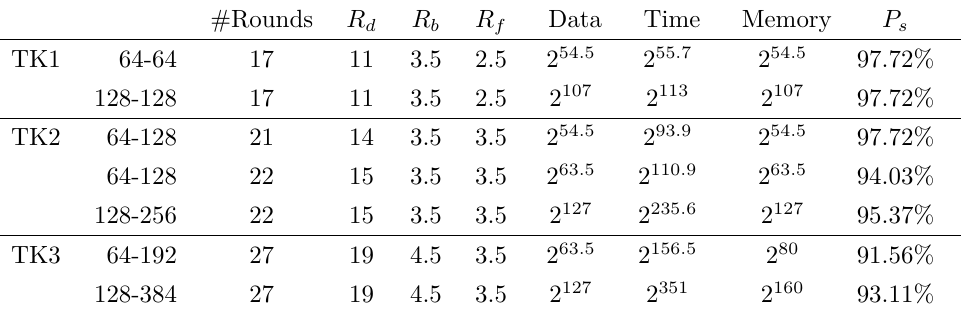
Table 5: Results of related-tweakey rectangle attack on